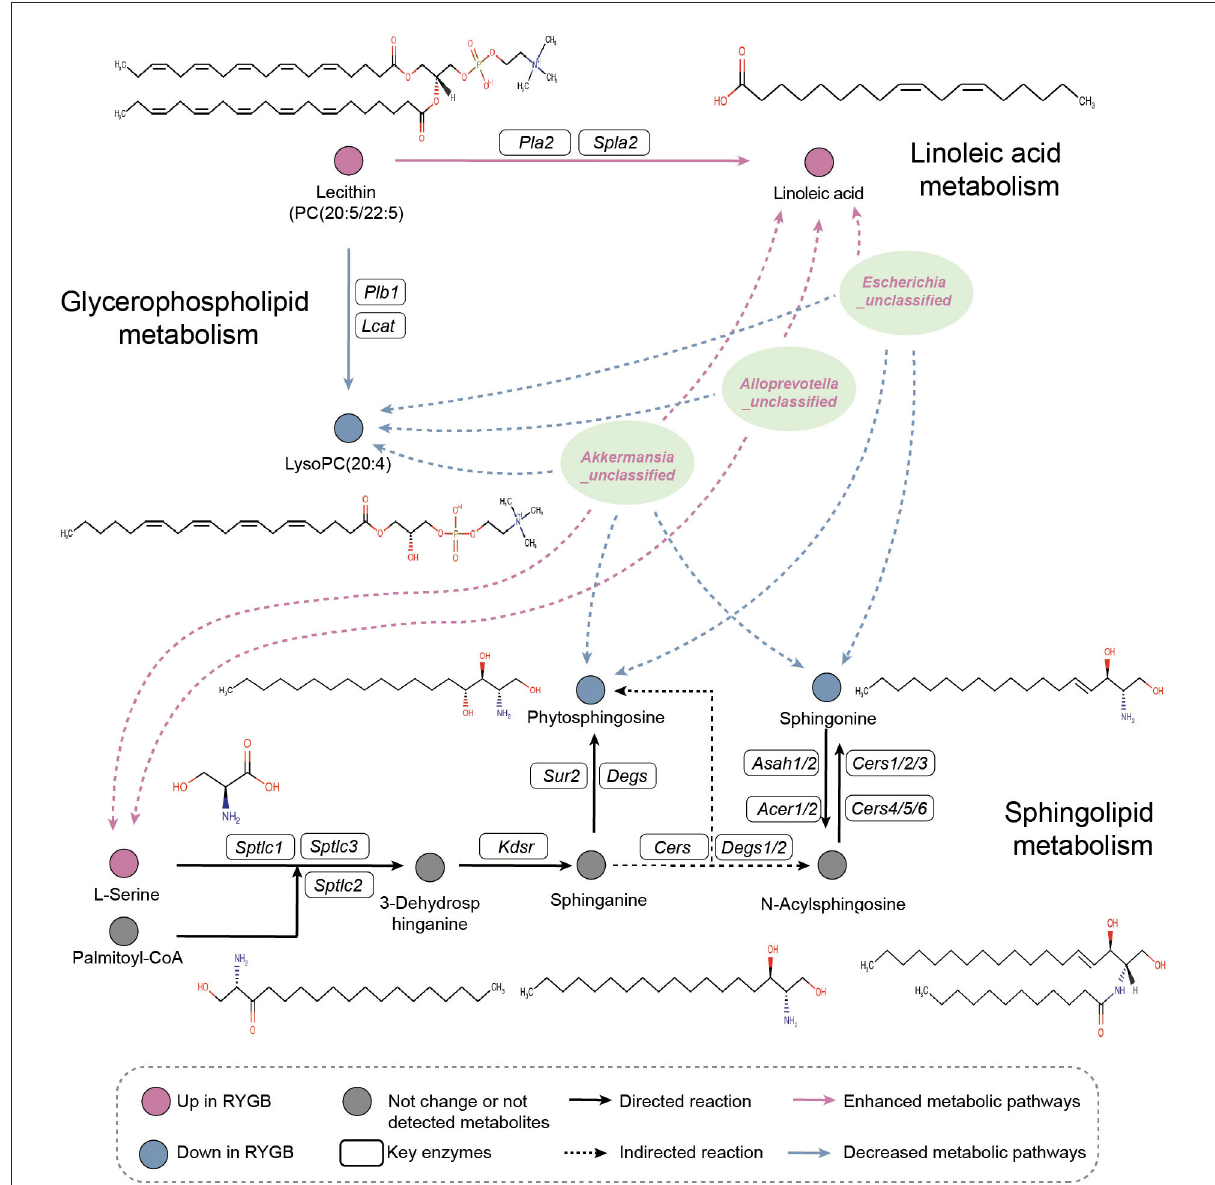
FIGURE6 Pathway analysis. Illustrative examples of metabolite changes in glycerophospholipid metabolism, linoleic acid metabolism, and sphingolipid metabolism pathways and their correlation with the RYGB enriched gut microbiome.